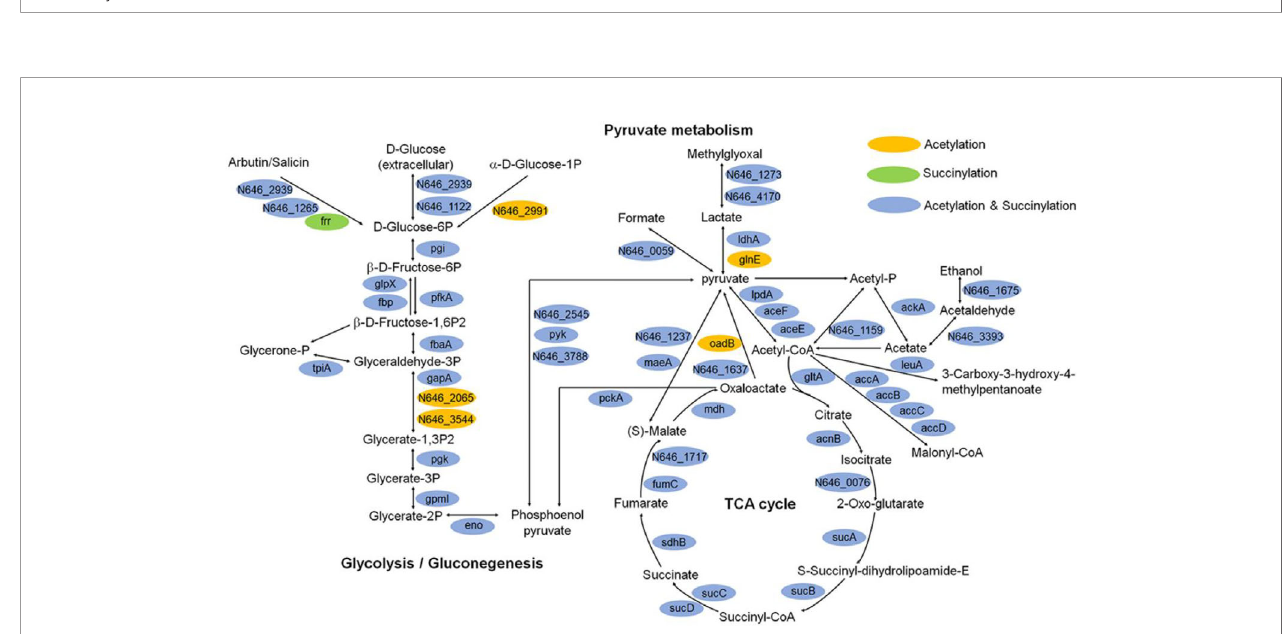
FIGURE 8 | Key enzymes with succinylation and acetylation modi fi cation in glycolysis/gluconeogenesis, TCA cycle, and pyruvate metabolism pathways.